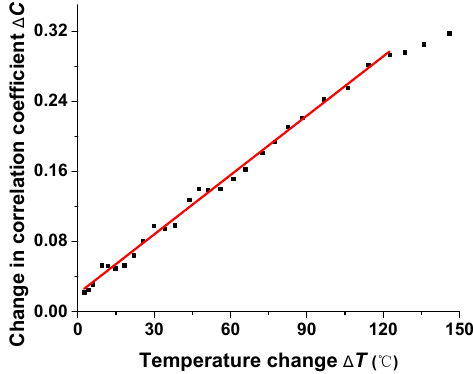
Figure 3. Sensing response for temperature change.